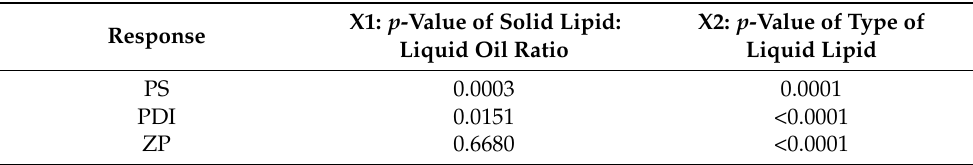
Figure 2. Graphical representation of the effects of ( A ) solid lipid: liquid oil ratio and ( B ) type of liquid oil on droplet size. Red dotted horizontal line and plus sign represent the average value over factor B at the focused point of factor A = 1.665, respectively. Green dotted lines represent 95% CI bands. Red circles and black squares represent design points and predicted values, respectively.